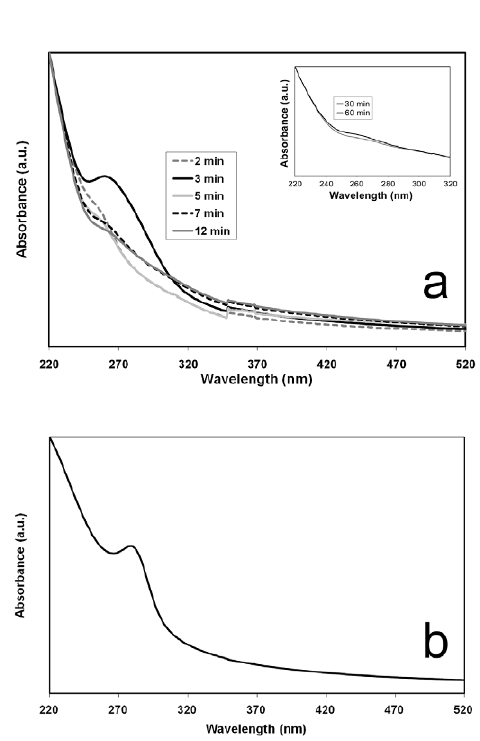
Figure 1. (a) UV-Vis absorption spectrum of ZnS QDs at 60°C for reaction times of 2 min, 3 min, 5 min, 7 min and 12 min. inset in (a) shows UV-Vis absorption spectrum of ZnS QDs at 60°C for reaction times of 30 min, 60 min; (b) at 120°C for 60